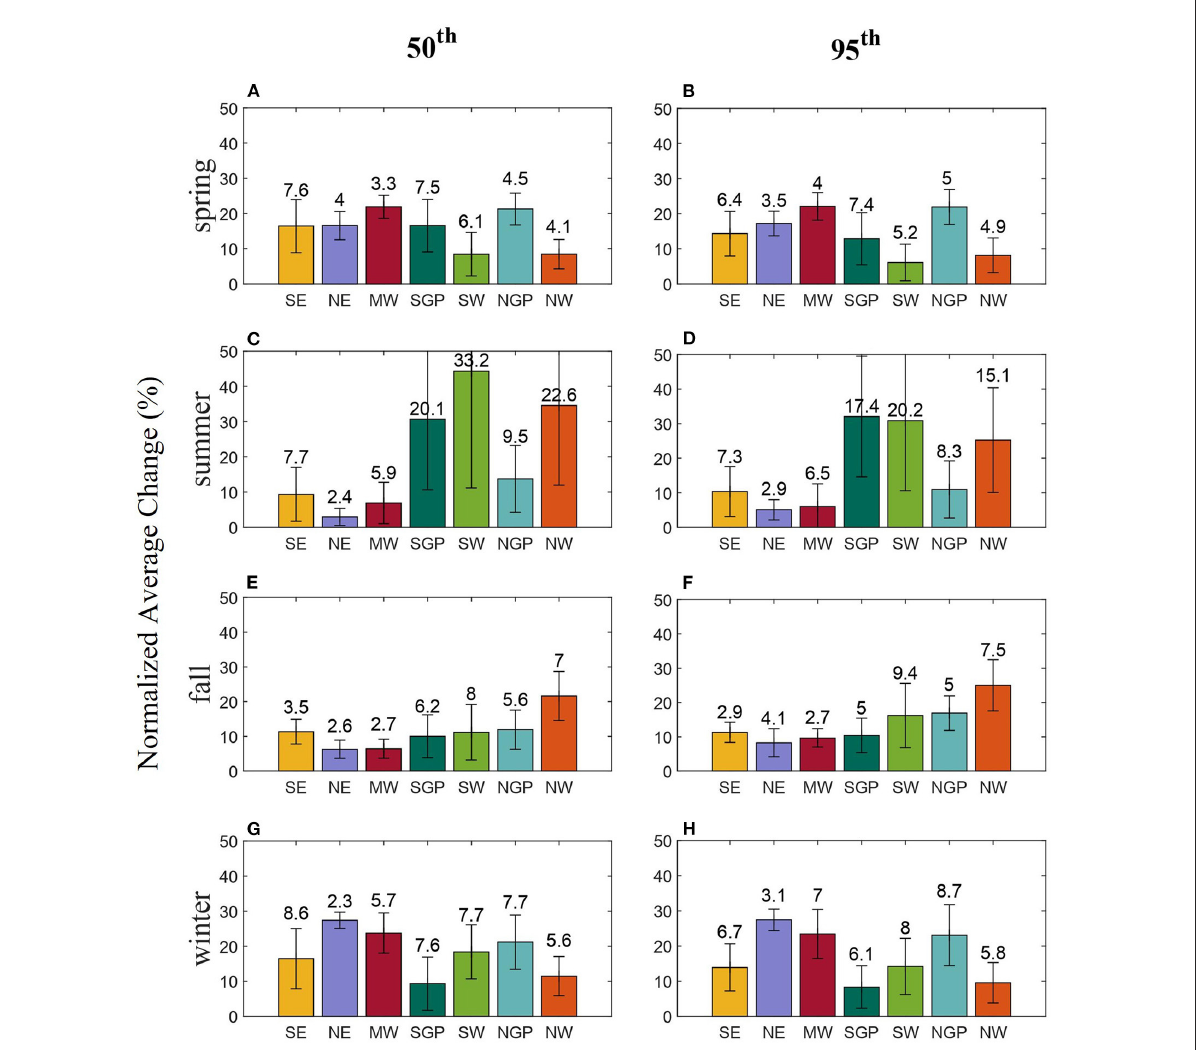
FIGURE6 Normalized regional average change of maximum seasonal total (mm) represented across seasons for the 50 th and 95 th quantiles compared to historical climatology from 1951 to 2014. Different color bar plots represent the regions of the National Climate Assessment (as shown in Figure 1), and the error bar represents the standard deviation of the normalized change within a region [spring (A) , summer (C) , fall (E) , winter (G) , spring (B) , summer (D) , fall (F) , and winter (H)